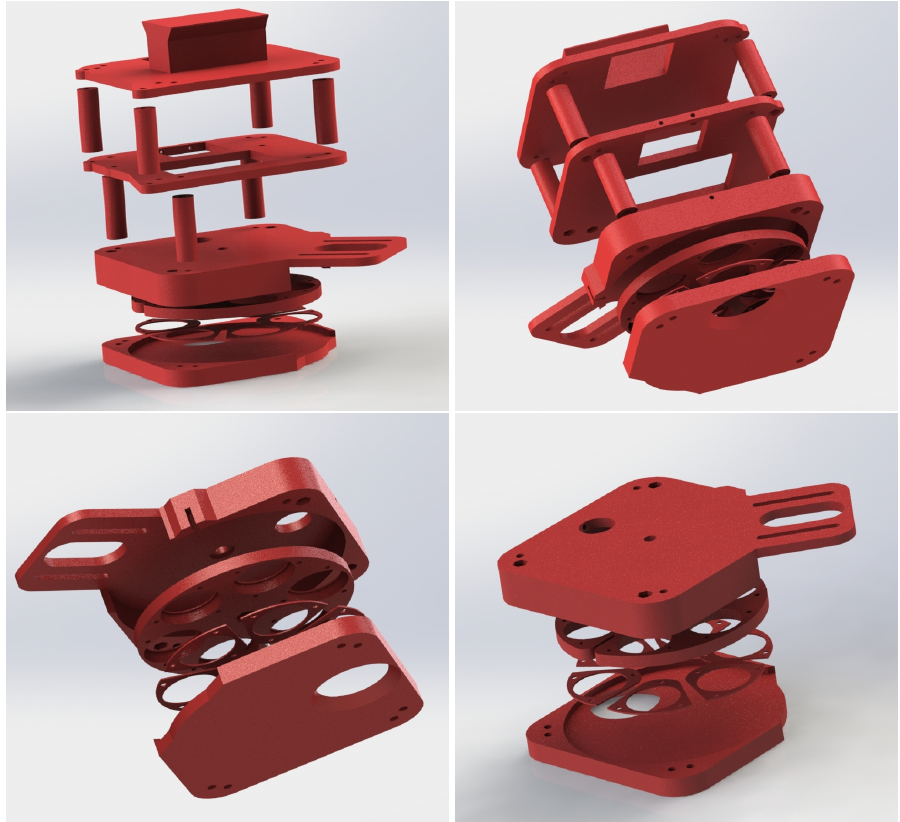
Figure 4. 3D model of the camera